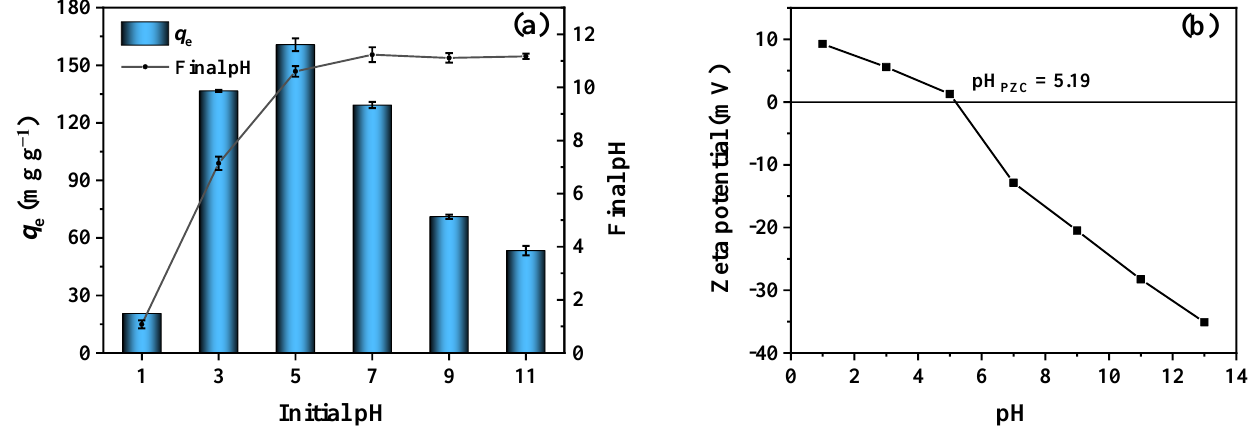
Figure 3. The effect of initial pH on phosphorus adsorption capacity ( a ) and Zeta potential determi- nation for 2MgO/BC-450-0.5 ( b ).